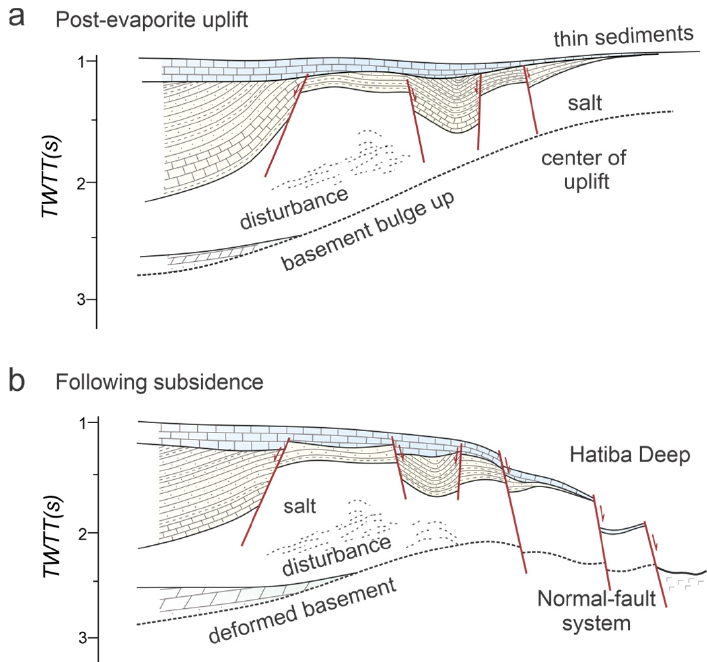
Figure 8. Sediment and tectonic evolution of the Hatiba Deep based on profile 060. ( a ) As the center of the Pliocene–Pleistocene uplift. ( b ) Intense tectonic subsidence controlled the formation of the deep. Lithologic patterns and unconformities refer to Figure 2.